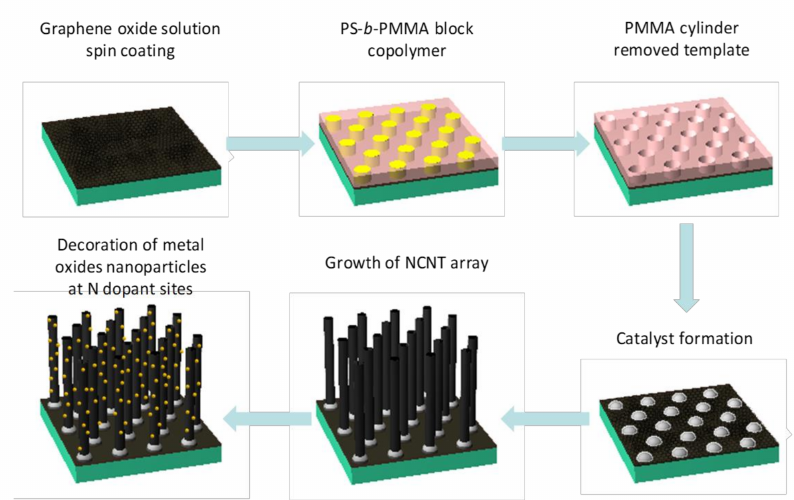
Figure 1. A schematic diagram for the procedure of metal oxide nanoparticle decoration on NCNTs.